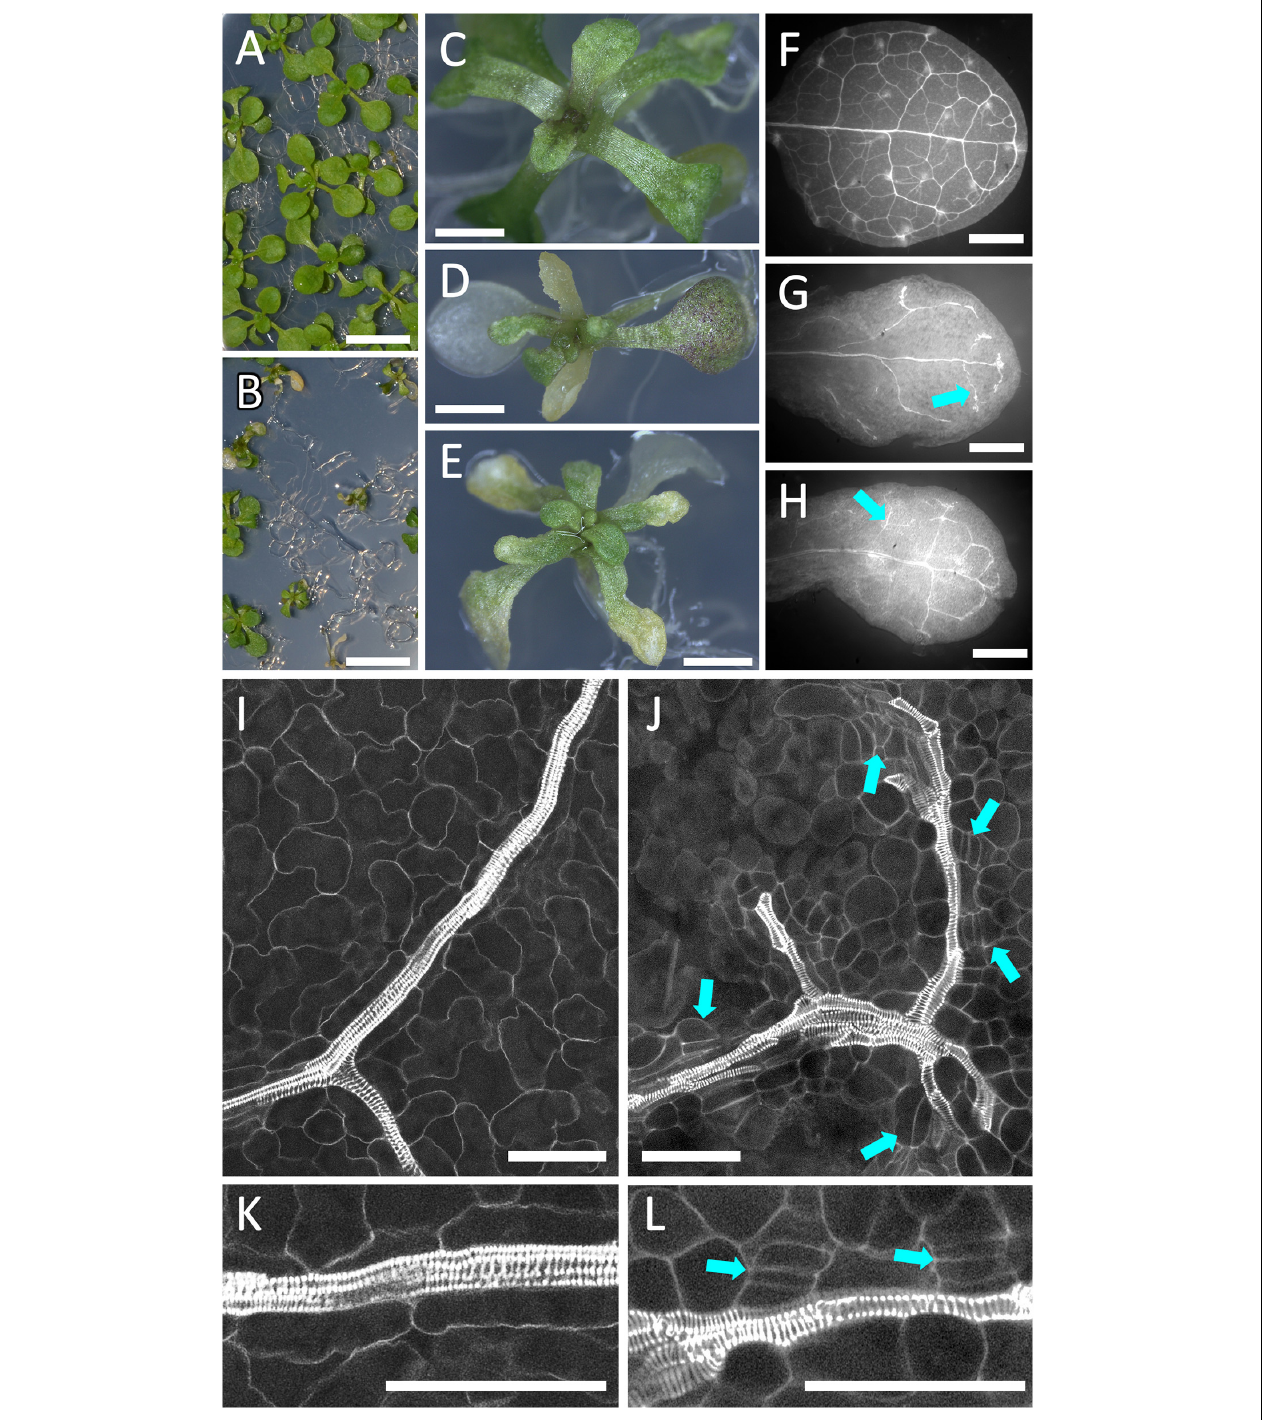
FIGURE 6 | Over-expression of PLL12 disrupts the development of leaf vasculature. (A–E) : pRPS5A:LhGR pOp:PLL12 plants growing for 4 days on medium containing dexamethasone (B,D,E) showed reduced growth and leaf chlorosis, in contrast to mock-treated plants (A,C) ; scale bars: 5 mm (A,B) , 2 mm (C–E) . (F–H) : Low magnification images of mPS-PI-stained leaves from an uninduced control (F) and two seedlings grown for 4 days on dexamethasone-containing medium (G,H) ; arrows indicate interrupted, uneven vasculature seen after PLL2 induction; scale bars: 200 µ m. (I–L) : Confocal images of leaf veins from seedlings comparable to panels (A–H) , grown without (I,K) or with dexamethasone (J,L) ; panels (K,L) are higher magnifications of panels (I,J) ; arrows indicate cell divisions oriented parallel to the veins, in a cambium-like pattern; scale bars: 50 µ m.